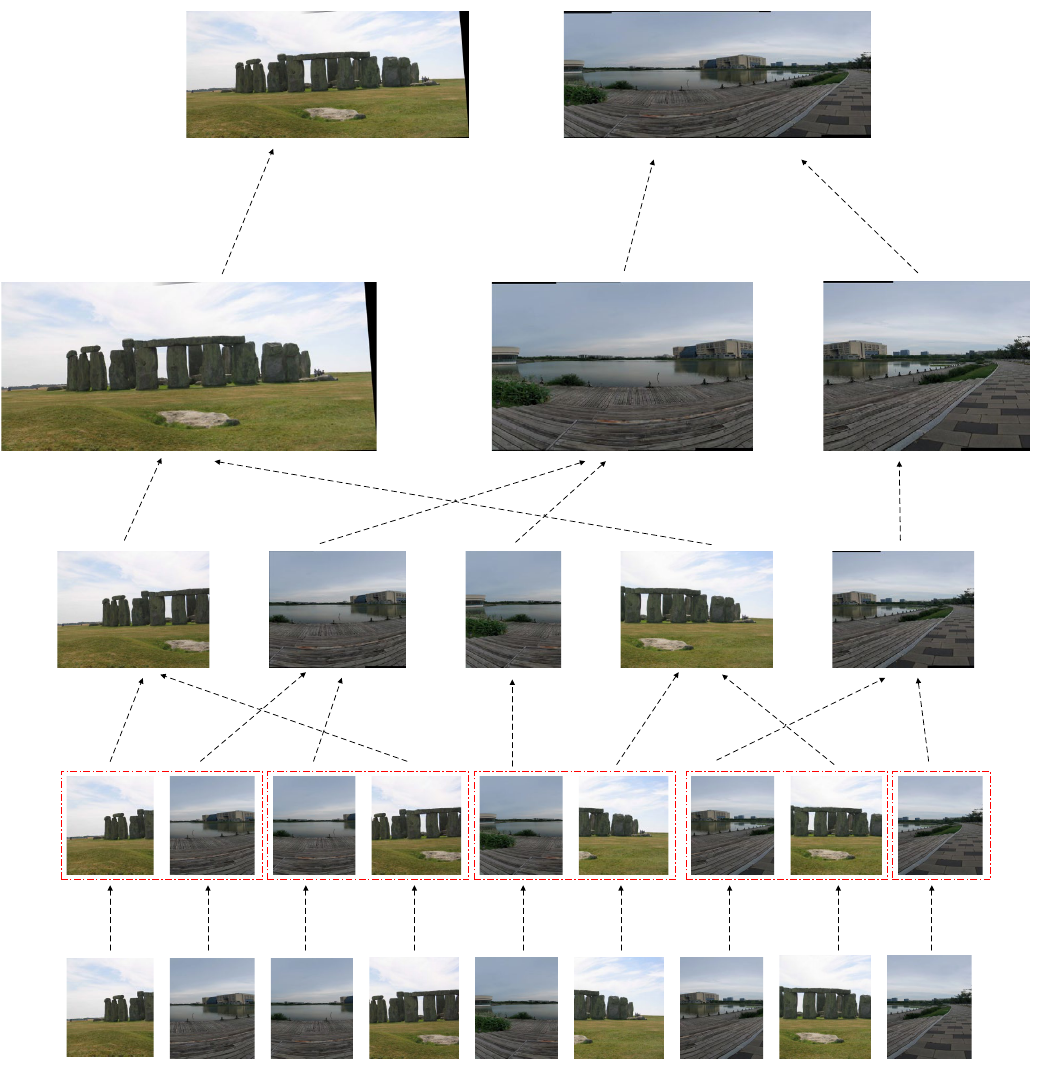
Figure 4. Stitching of unordered images of two scenes. Scene 1 consists of four images; scene 2 consists of five images.